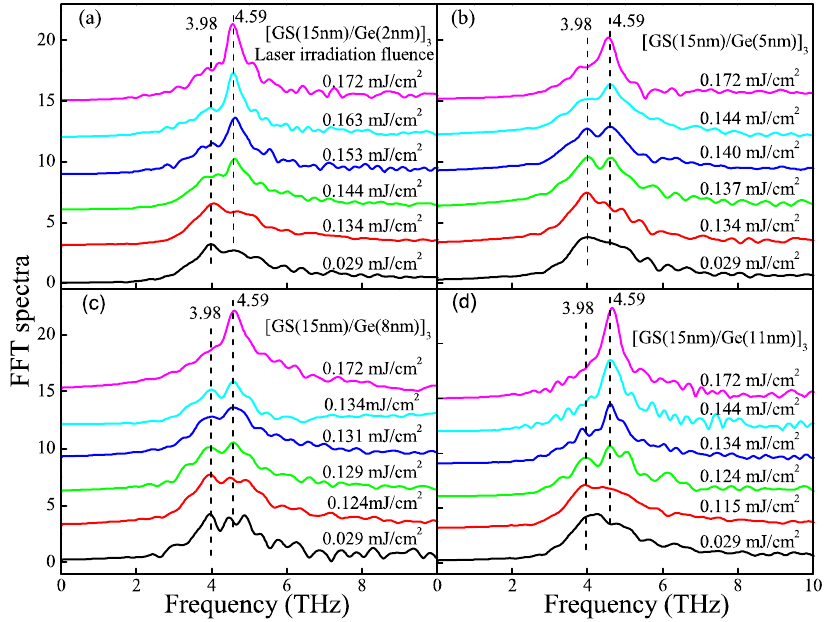
Figure 3. Fast Fourier transform (FFT) spectra of coherent phonon oscillations corresponding to the dynamics in Figure 2. ( a ) [Ge 8 Sb 92 (15 nm)/Ge(2 nm)] 3 . ( b ) [Ge 8 Sb 92 (15 nm)/Ge(5 nm)] 3 . ( c ) [Ge 8 Sb 92 (15 nm)/Ge(8 nm)] 3 . ( d ) [Ge 8 Sb 92 (15 nm)/Ge(11 nm)] 3 . The curves are shifted vertically for